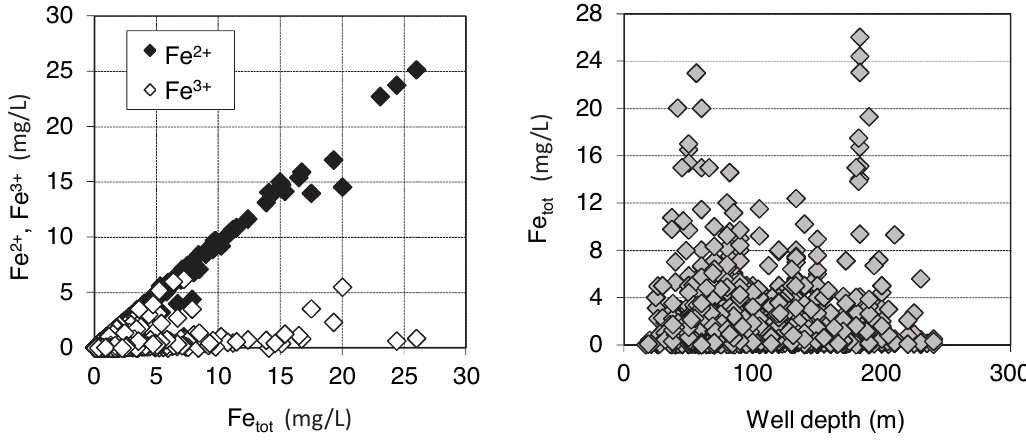
Fig. 4. The proportion of Fe 2+ and Fe 3+ in Fe tot concentration and bivariate plot of the Fe tot content versus well depth in ground